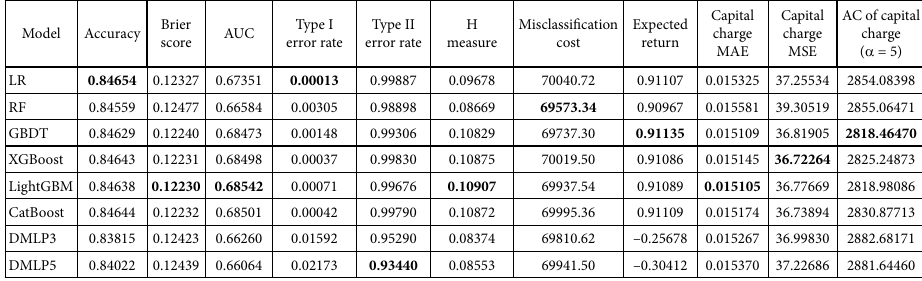
Table 3. Results of out-of-sample validation for Lending club